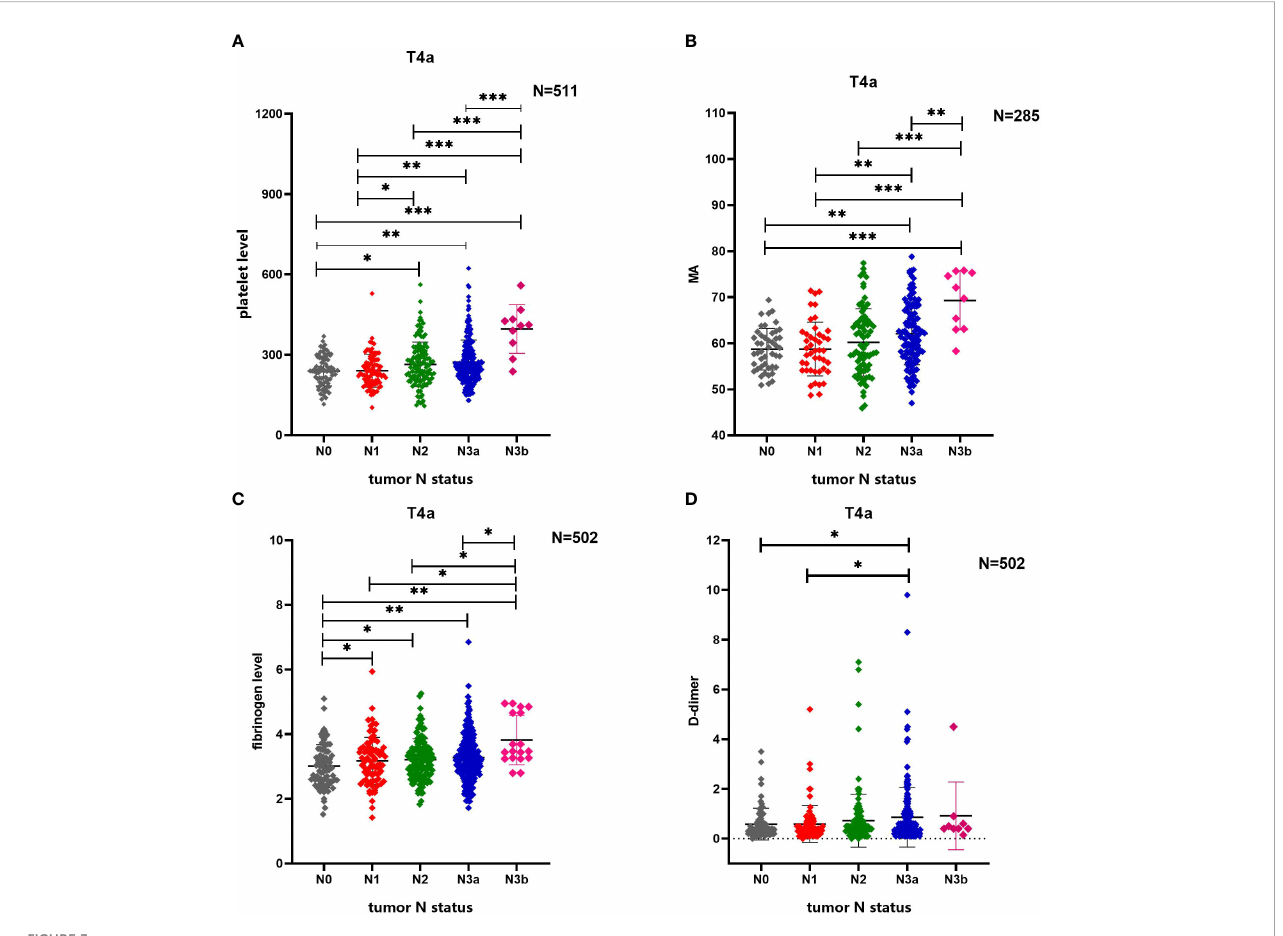
FIGURE 3 Comparison of differences in multiple coagulation-related factors according to tumor N stage of patients with gastric cancer. (A) Tumor N stage of patients with gastric cancer is related to platelet level. (B) Tumor N stage of patients with gastric cancer is related to MA. (C) Tumor N stage of patients with gastric cancer is related to fi brinogen level. (D) Tumor N stage of patients with gastric cancer is related to D-dimer. * 0.01 ≤ P<0.05, ** 0.001 ≤ P<0.01, ***